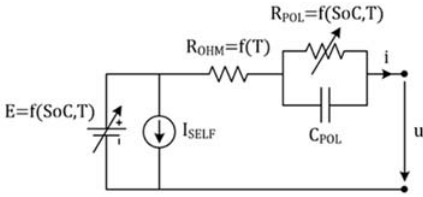
Figure 1. The battery equivalent circuit used in this work updated with temperature dependencies.